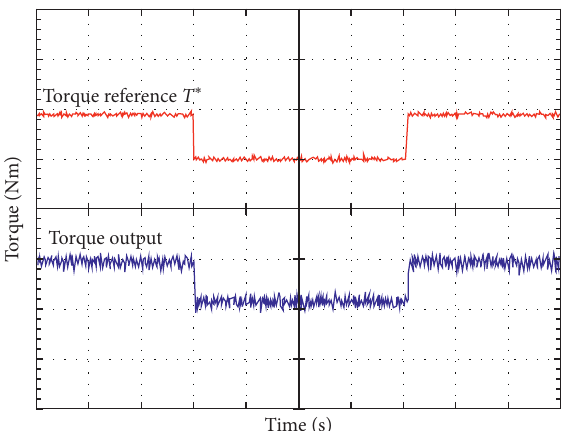
Figure 16: Experimental torque response with a torque reference T ∗ � ± 1 Nm, torque band H torque amplitude is 2Nm/div, and the period is